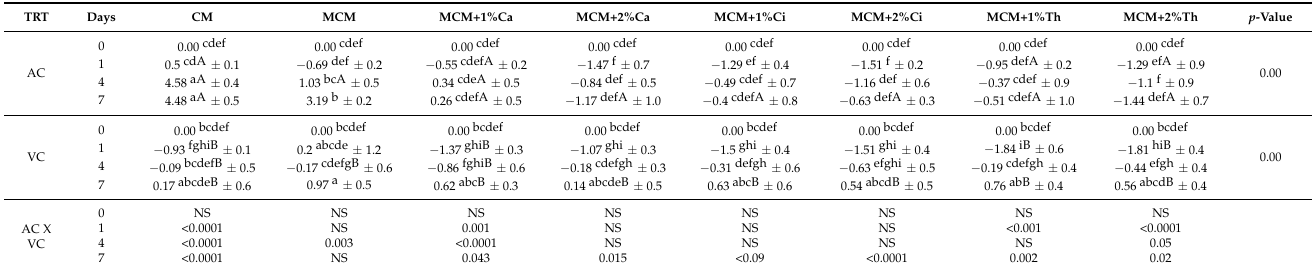
Table 4. Population changes of yeast and molds (log (N0/N) ± SD CFU/g) in marinated camel meat with essential oils under aerobic (AC) and vacuum (VC) conditions after storage at 10 ◦ C for 0, 1, 4 and 7 days. TRT